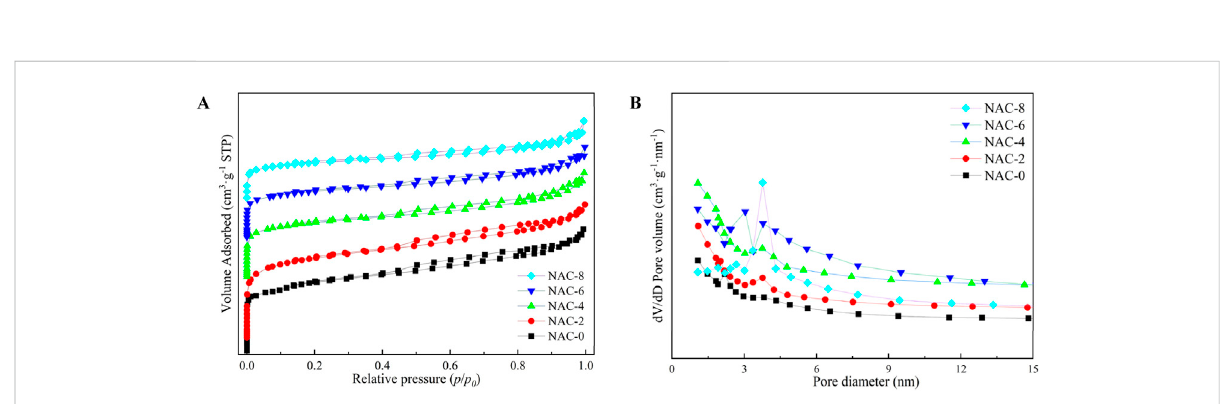
FIGURE 3 Pore structure analysis: (A) N 2 sorption isotherms; (B) pore-size distributions of the as-prepared AC